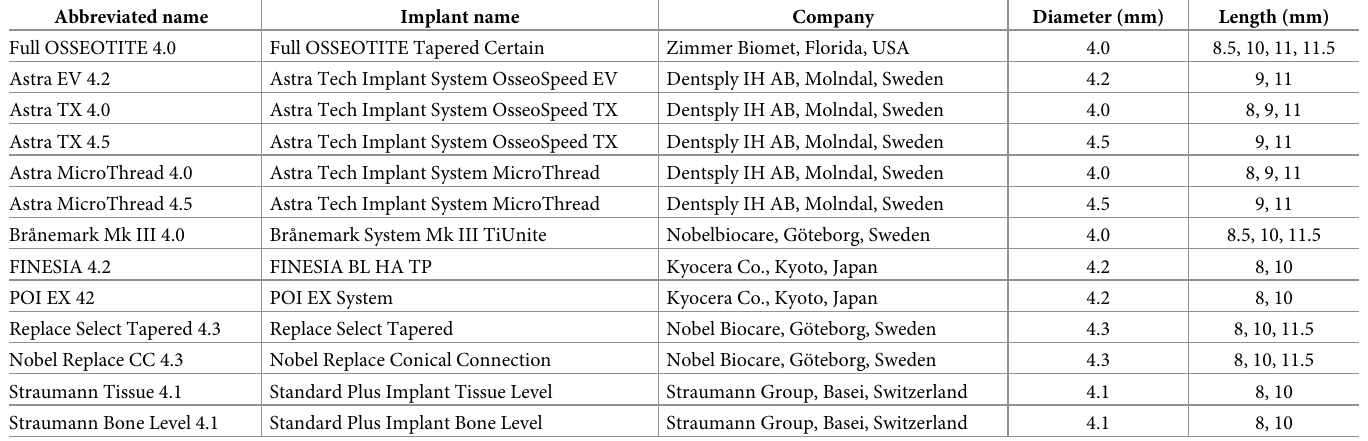
Table 1. Summary of thirteen types of dental implant